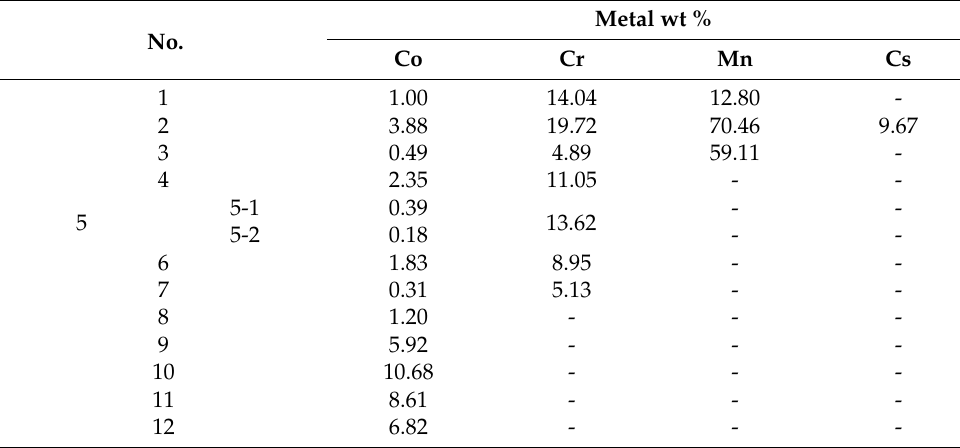
Table 5. Percentage of the surrogate nuclides captured in the slag.